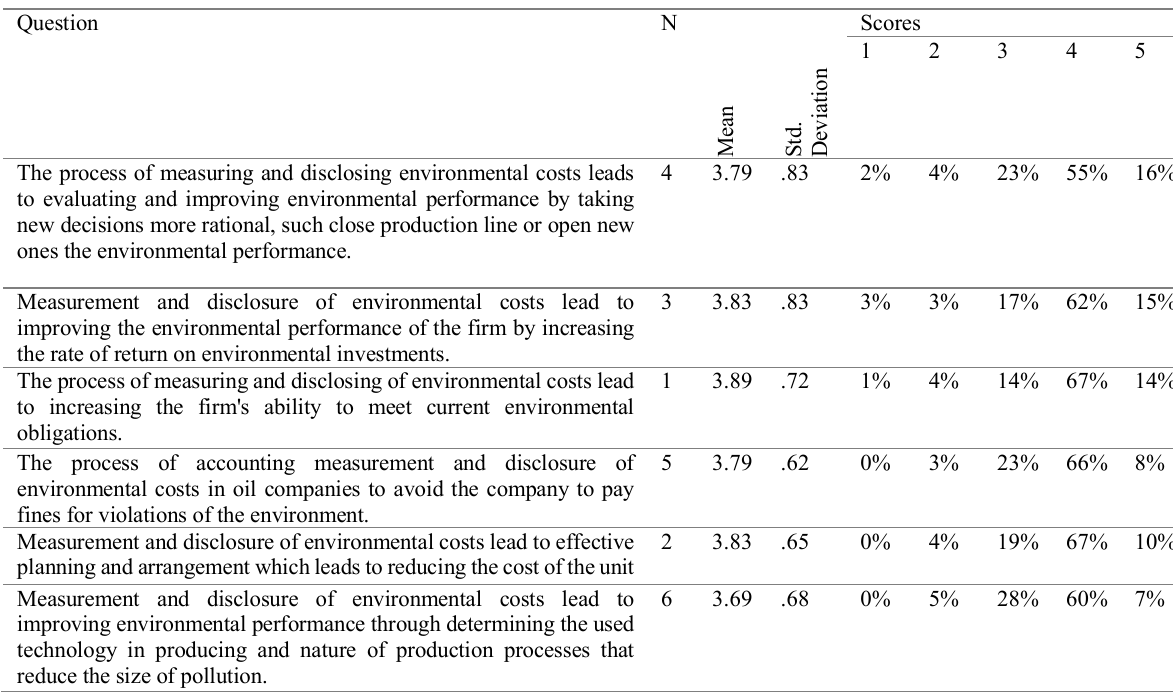
Table 10: Relationship between environmental costs and the decision-making process.